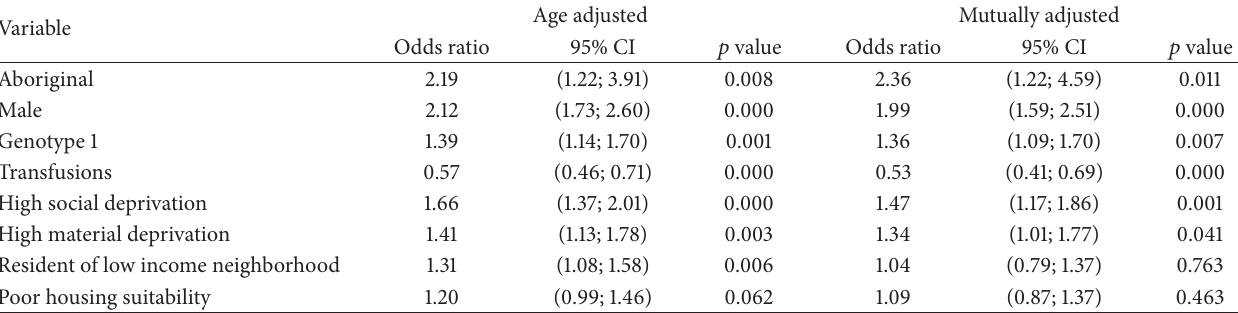
Table 3: Age adjusted and mutually adjusted associations between clustering of four or more HCV risk factors and Aboriginal status, characteristics of HCV infection, and markers of socioeconomic